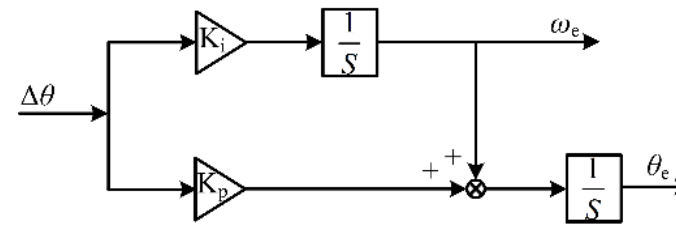
Figure 4. The principal block diagram of PLL.